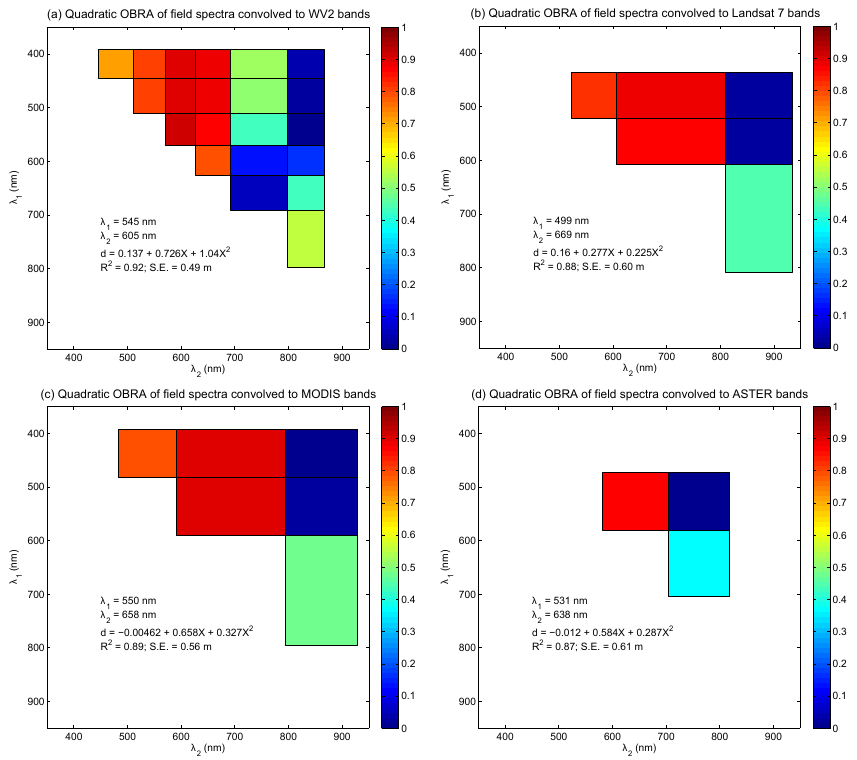
Fig. 4. Quadratic optimal band ratio analysis (OBRA) of field spectra aggregated across the three sites and convolved to the sensor bands for (a) WV2, (b) Landsat 7, (c) MODIS, and (d)